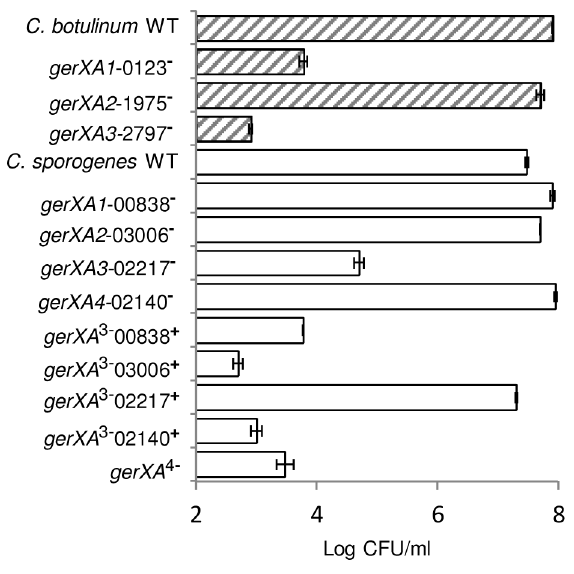
Figure 6. Capacity of WT or mutant spores to germinate and form colonies. C. botulinum and C. sporogenes wild type and mutant spore suspensions were enumerated using a haemocytometer and adjusted to a final concentration of , 1 6 10 8 spores/ml. Spores were heat activated (80 u C, 15 min), serially diluted in 0.85% saline, and plated in triplicate on to TY agar before anaerobic incubation (37 u C, 48 hrs), after which colonies were enumerated. Data presented represent the mean log 10 colony-forming units/ml from triplicate plates, with error bars representing the standard deviation of the mean.